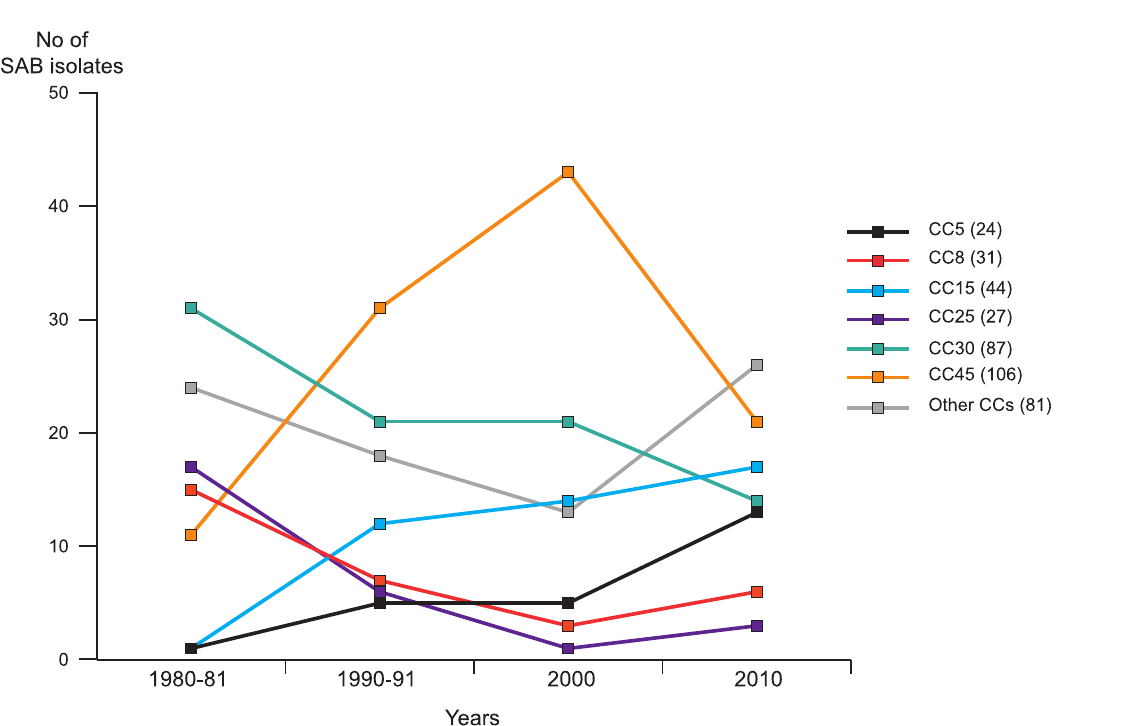
Figure 2. Distribution of SAB isolates assigned to CCs during the study period. Of 6 predominant CCs (CC5, CC8, CC15, CC25, CC30, and CC45), SAB isolates assigned to CC5 and CC15 showed a trend towards an increased prevalence over the study period, and isolates assigned to CC8, CC25, and CC30 declined. The numbers in parentheses indicate the total number of isolates within each CC. CC30 includes CC30 (ST34/42). Other CCs: CC1, CC6, CC7, CC9, CC12, CC20, CC22, CC49, CC50, CC59, CC97, CC101, CC121, CC182, CC188, CC395, CC398, and ST2319.